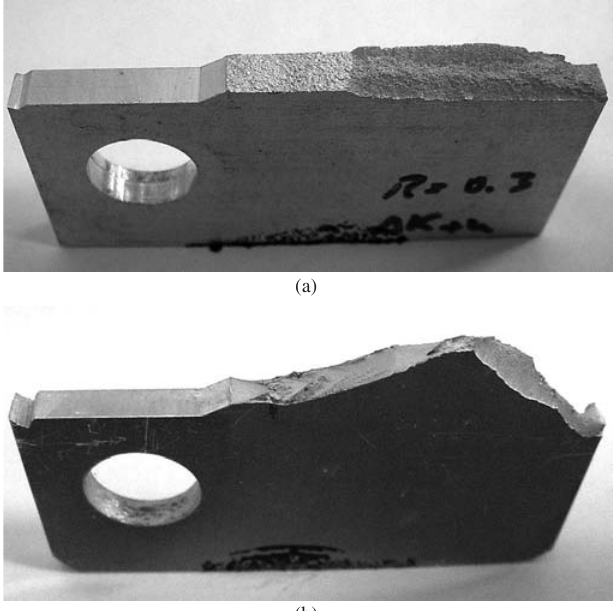
Figure 7. Fracture surfaces, a) Al 2024; and b) Al 8090.